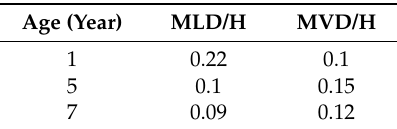
Table 3. Relationships between the tree height (H) and the maximum lateral distance (MLD) and maximum vertical depth (MVD) of the root